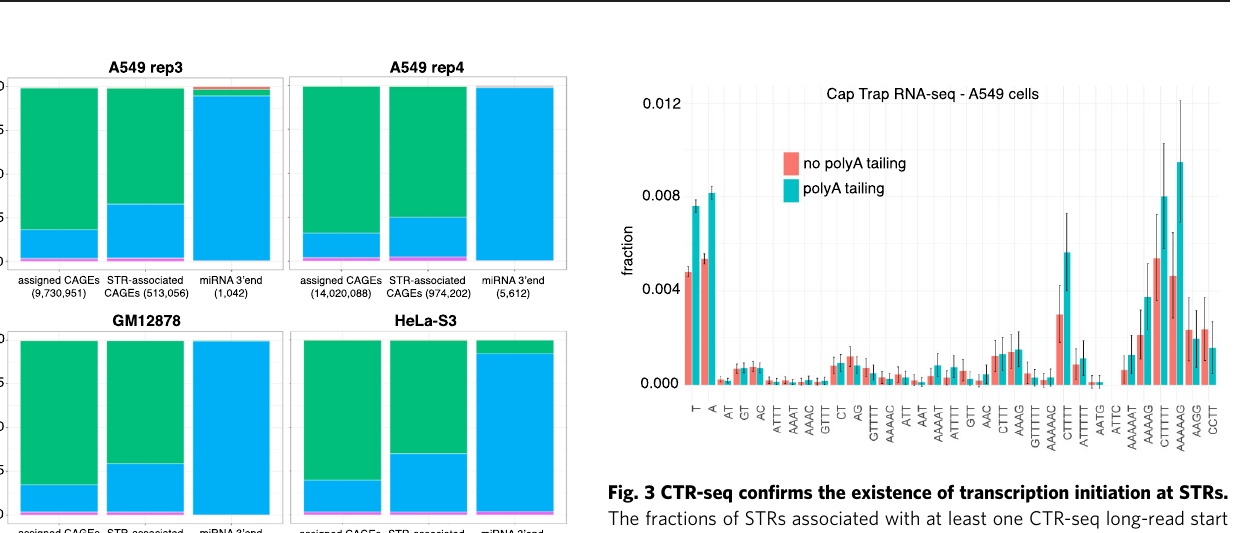
Fig. 1 CAGE peaks are detected at STRs. a Three examples of STRs associated with a CAGE peak. The Zenbu browser 79 was used. top track, hg19 genome sequence; middle track, CAGE tag count as mean across 988 libraries (BAM fi les with Q3 fi lter were used); bottom track, CAGE peaks as called in ref. 2 . b Number of STRs per STR class. For sake of clarity, only STR classes with >2000 loci are shown. c Fraction of STRs associated with a CAGE peak in all STR classes considered in b . d CAGE signal at STR classes with >2000 loci. CAGE signal was computed as the mean raw tag count of each STR (tag count in STR ± 5 bp) across all 988 FANTOM5 libraries. This tag count was further normalized by the length of the window used to compute the signal (i.e., STR length + 10 bp). The orange bar corresponds to the median value. The lower and upper hinges correspond to the fi rst and third quartiles (the 25th and 75th percentiles). The upper whisker extends from the hinge to the largest value no further than 1.5 × IQR from the hinge (where IQR is the interquartile range or distance between the fi rst and third quartiles). The lower whisker extends from the hinge to the smallest value at most 1.5 × IQR of the hinge. Data beyond the end of the whiskers are plotted individually.